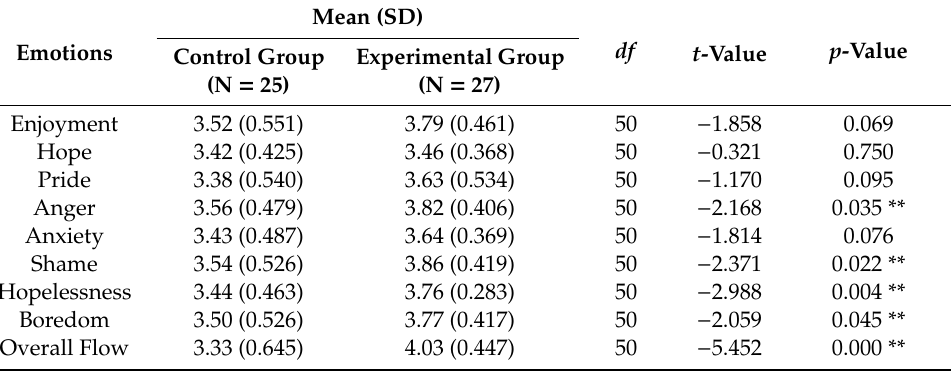
Table 8. Learning emotional manifestation of eight